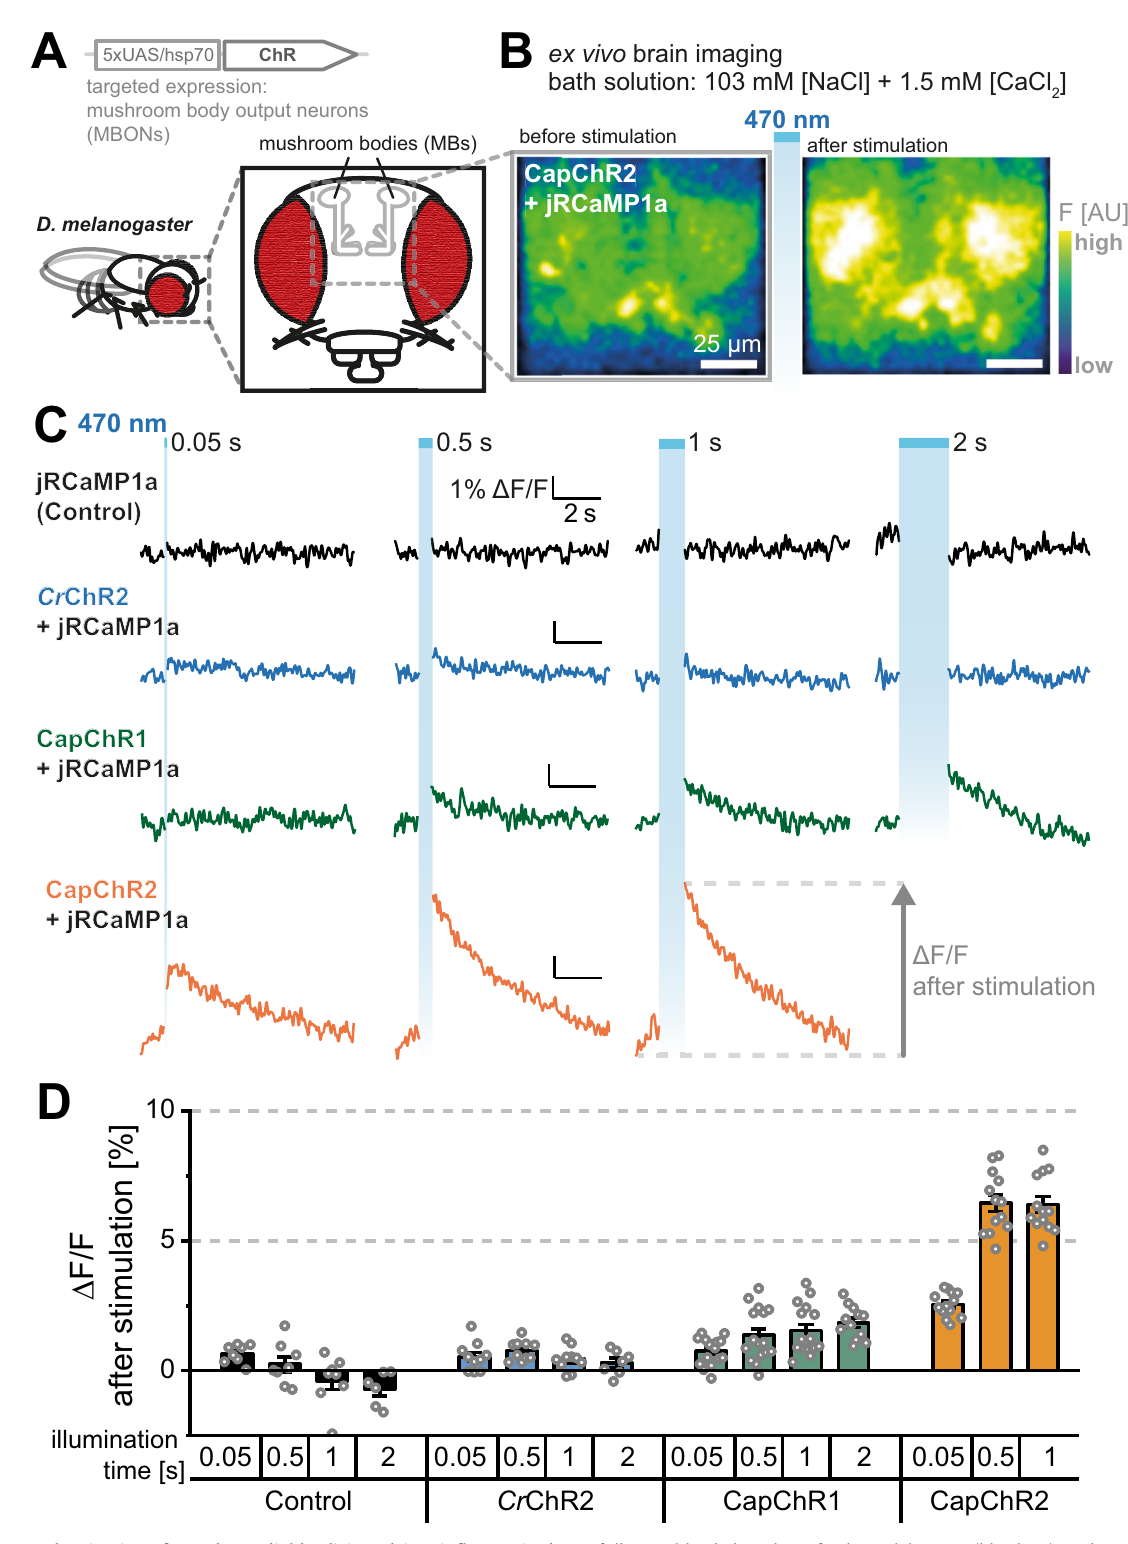
Fig. 7 | Targeted activation of CapChR2 reliably elicits calcium in fl ux to single Drosophila neurons. A Expression of UAS-CapChR1, UAS-CapChR2 and UAS- Cr ChR2 was targeted to M4/6 mushroom body output neurons using the VT1211- Gal4 driver line. B Blue-light (470nm, ~4.5mW/cm 2 ) activation of CapChR2 elicits marked calcium increaseinM4/6neurons, measured withco-expressed jRCaMP1a in Drosophila explantbrainpreparations. C ExamplejRCaMP1a fl uorescencetraces